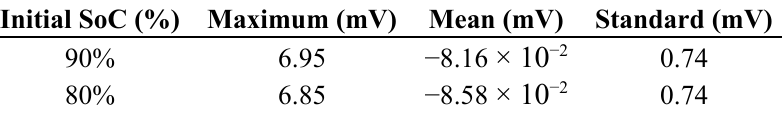
Figure 16. The voltage prediction results of the LiMn 2 O 4 cell: ( a ) Voltage; ( b ) Voltage error. Table 6. Statistical results of the voltage prediction error.